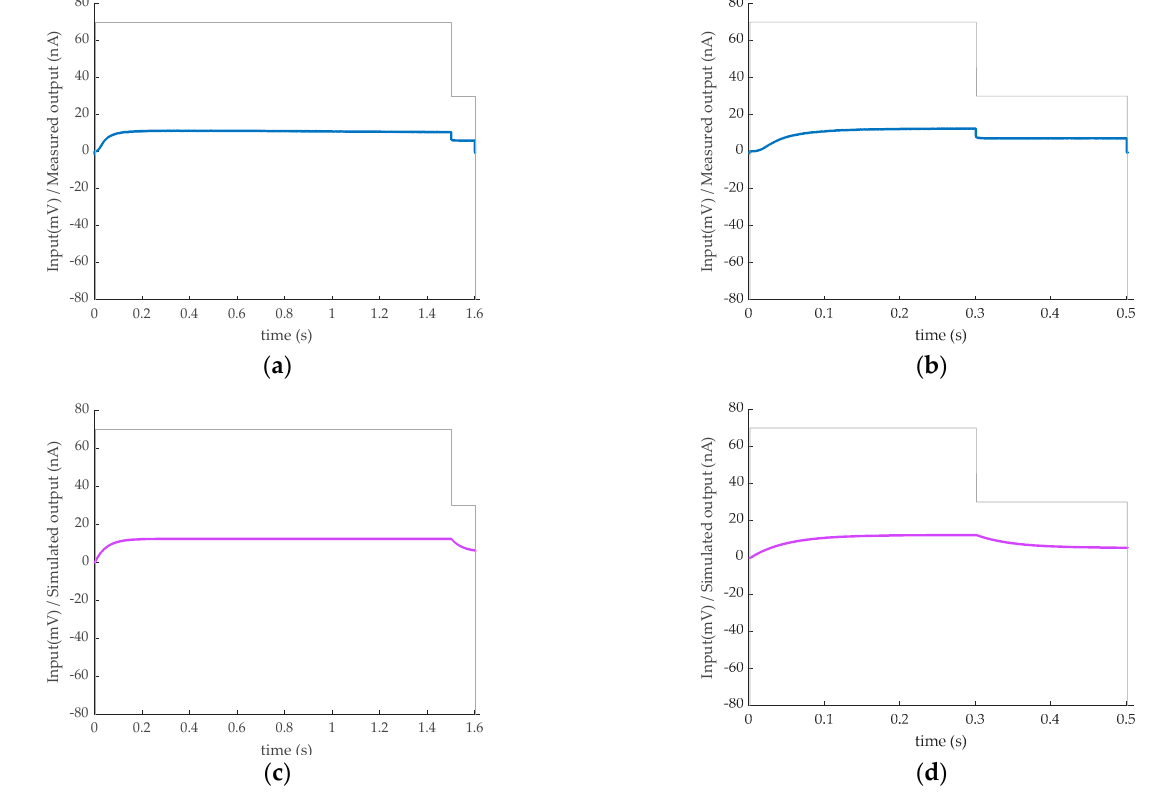
Figure 7. Measured and simulated output macroscopic current for the inactivation and deactivation input stimuli (grey lines). Input stimulus inactivation: measured output ( a ), simulated output ( b ); input stimulus deactivation: measured output ( c ), simulated output ( d ).